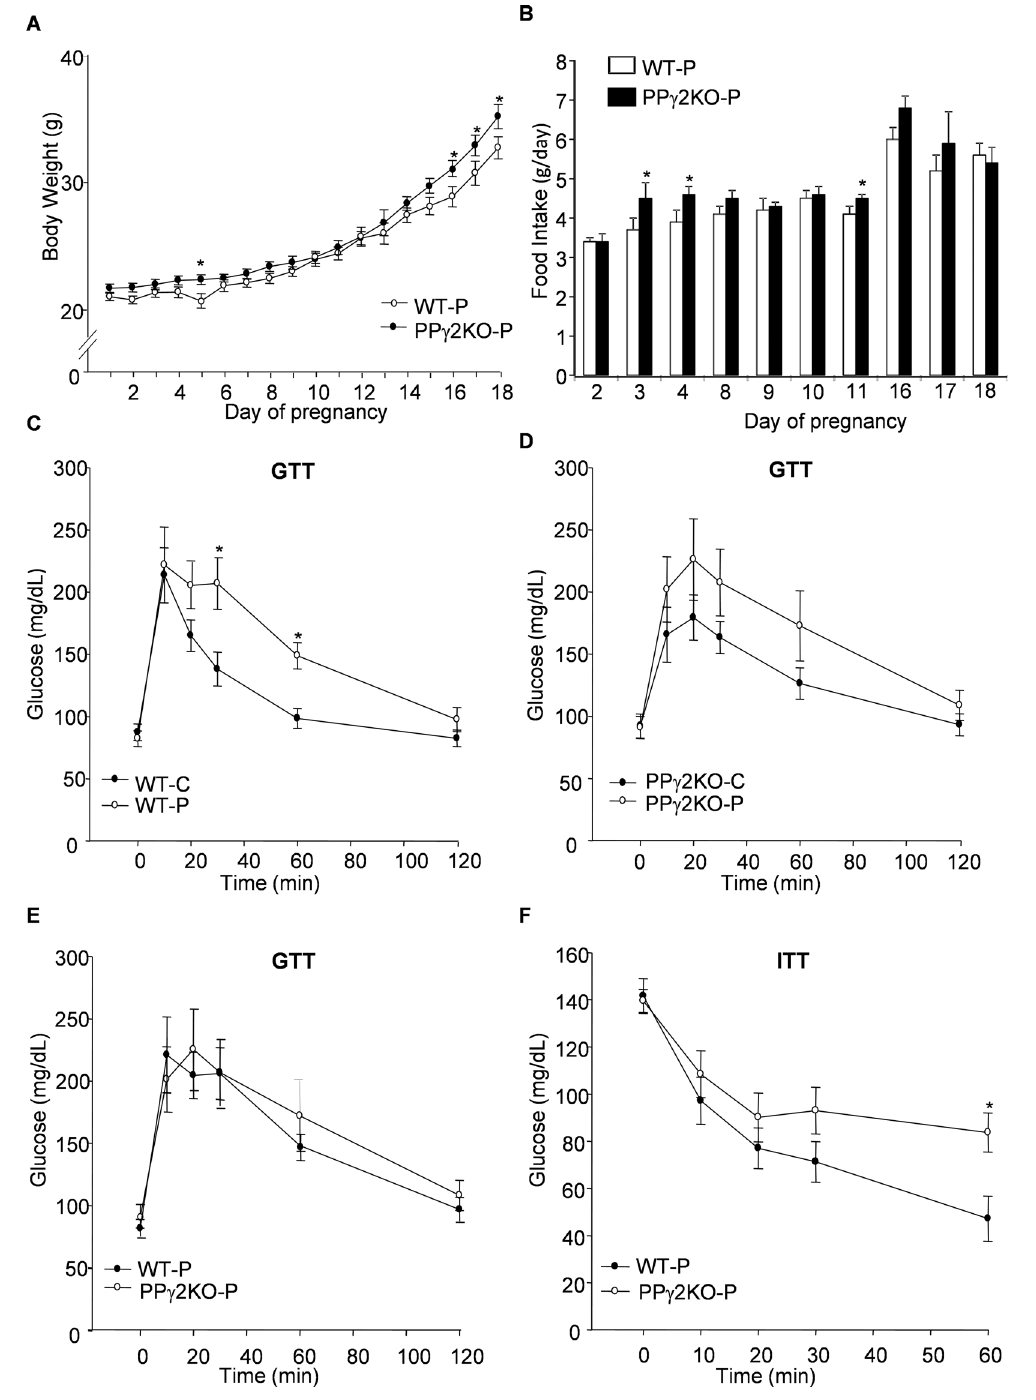
Figure 1. Alteration in body weight, food intake and insulin sensitivity in PPAR γ 2KO mice during pregnancy. (A) Evolution of body weight in pregnant mice with deletion of PPAR γ 2 (PP γ 2KO-P) and in corresponding pregnant WT (WT-P) animals. (B) Changes in food intake during pregnancy. Food intake was measured every 24 h. Data from the first, second and third phase of pregnancy are shown. (C) GTT curves from nonpregnant and pregnant WT mice, (D) from nonpregnant and pregnant PP γ 2KO mice and (E) from pregnant WT and PP γ 2KO mice. All mice were at d 15 of gestation. (F) ITT curves from pregnant WT and PP γ 2KO mice at d 16 of gestation. Data are ex- pressed as mean ± SEM (A, B: n = 10–15 animals/group; C–F: n = 9–11 animals/group). * p ≤